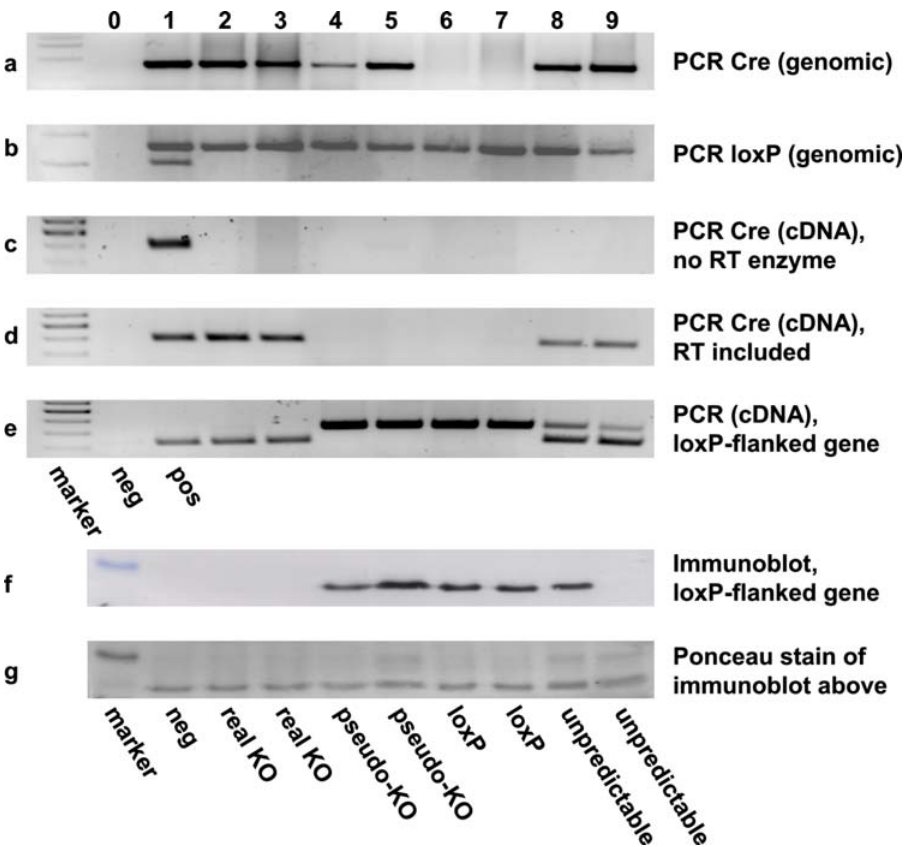
Figure 1. Genotyping and molecular phenotype analysis for hepatocyte specific gene inactivation in the mouse by the Cre/loxP-technique. (a) Cre-transgene detection by PCR with genomic DNA as template. Columns 0 and 1 depict negative and positive control, respectively (also applies to subsequent panels B to E). (b) Amplification of genomic DNA for detection of loxP flanked exon 4 of the frataxin gene. A double band depicts heterozygous genotype (column 1), one band at 545 bp only accordingly indicates homozygous loxP insertion (columns 2 to 9). (c) Control Cre-PCR from RNA without reverse transcription. (d) RT-PCR of Cre RNA expression. (e) RT-PCR directed at floxed exon 4 of the target gene. The shorter band stems from RNA with excised exon 4, the long band corresponds to the intact loxP flanked exon 4. (f) Immunodetection of Cre/loxP-targeted frataxin expression in the liver. (g) Ponceau staining of membrane before immunodetection to ensure equal loading of protein in all columns.